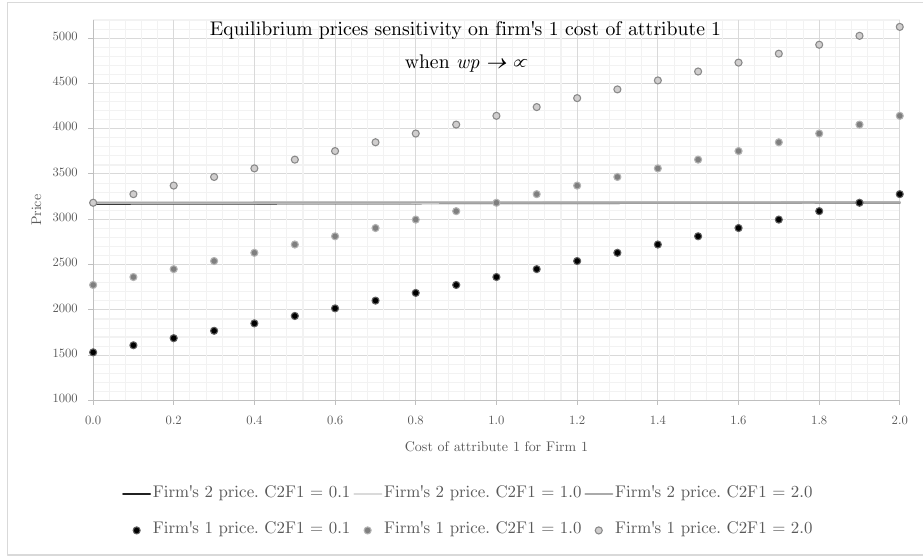
Figure A2. Price for firms varying attributes’ costs of Firm 1 when wp (cid:29) 0.